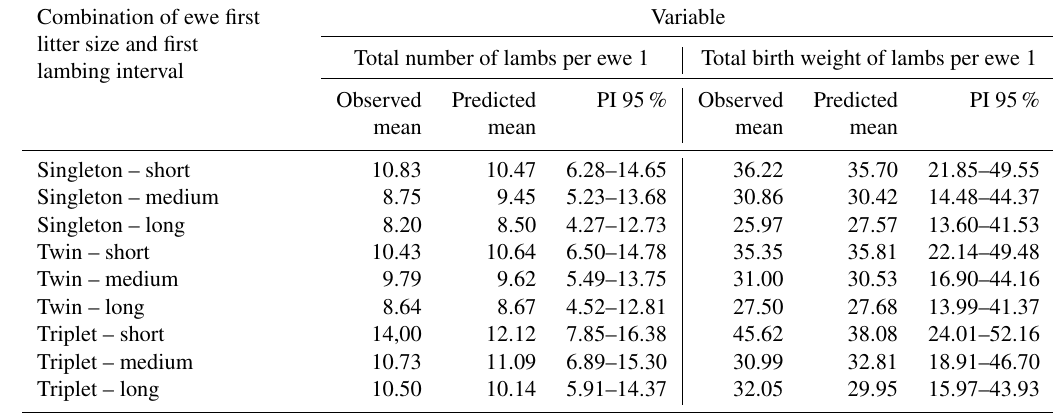
Table 4. Means and prediction intervals of reproductive performance up to the fourth year of ewe’s life for the combination of first litter size and first lambing interval.